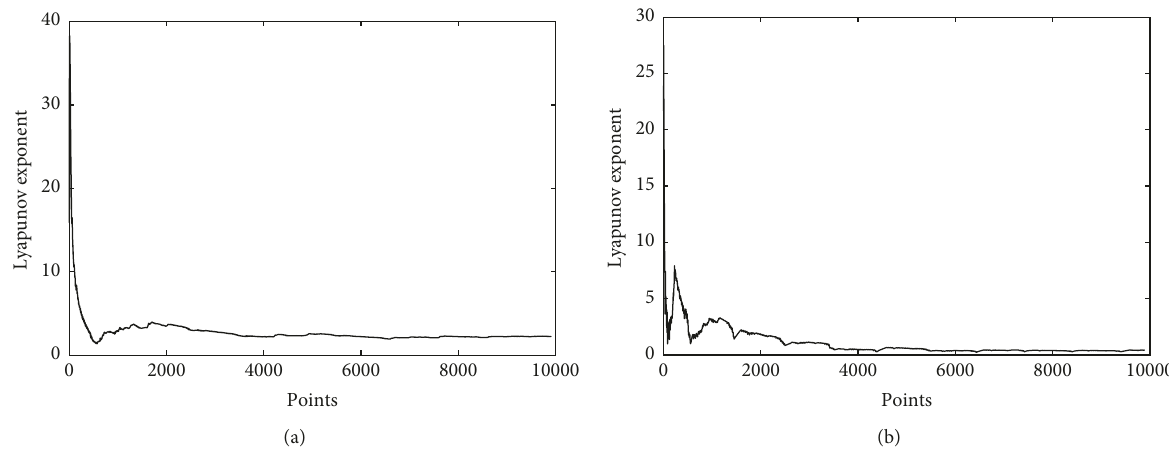
Figure 10: Lyapunov exponent: (a) Lyapunov exponent in x direction; (b) Lyapunov exponent in y direction. ×10 –3